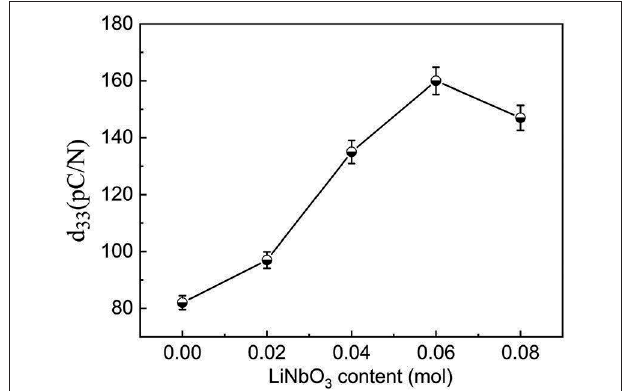
FIGURE 3 | (a) Effect of temperature on the dielectric properties at 10kHz for KNBNNO-xLiNbO 3 ceramics with 0 ≤ x ≤ 0.08; (b) the inverse dielectric constant (1/ ε ) varies with temperature at 10kHz; (c) T C and T O − T change with LiNbO 3 content; (d) Thermal stability of the relative permittivity ( 1 ε / ε 40 ◦ C ) change with temperature for the (1-x)KNBNNO-xLiNbO 3 (x = 0.00–0.08) ceramics at 10kHz.